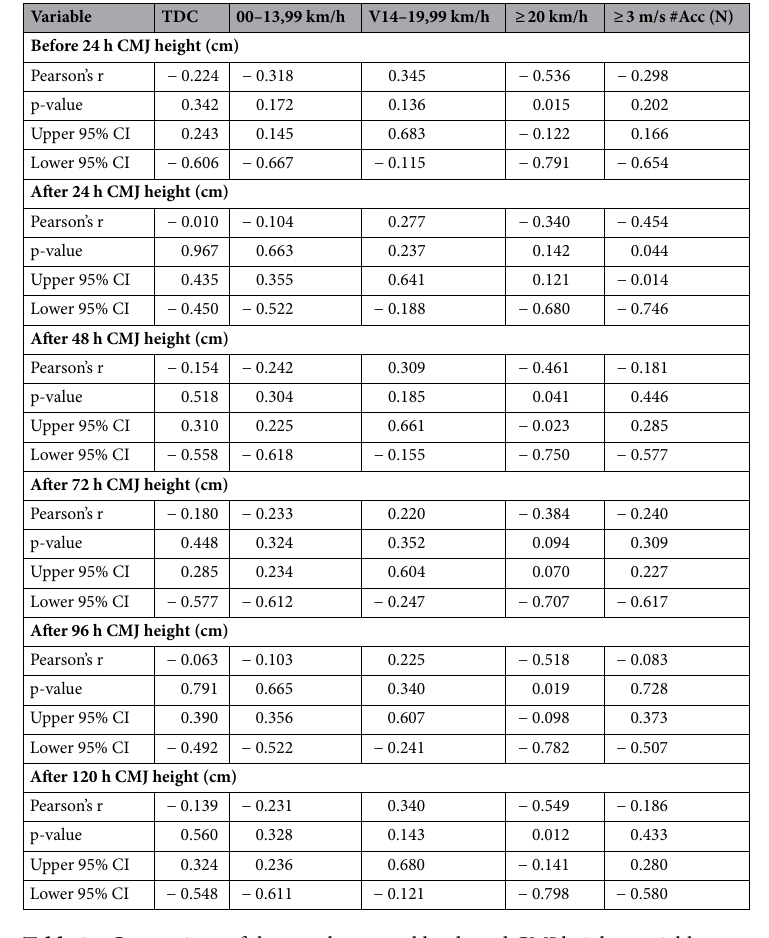
Table 3. Comparison of the match external loads and CMJ heights